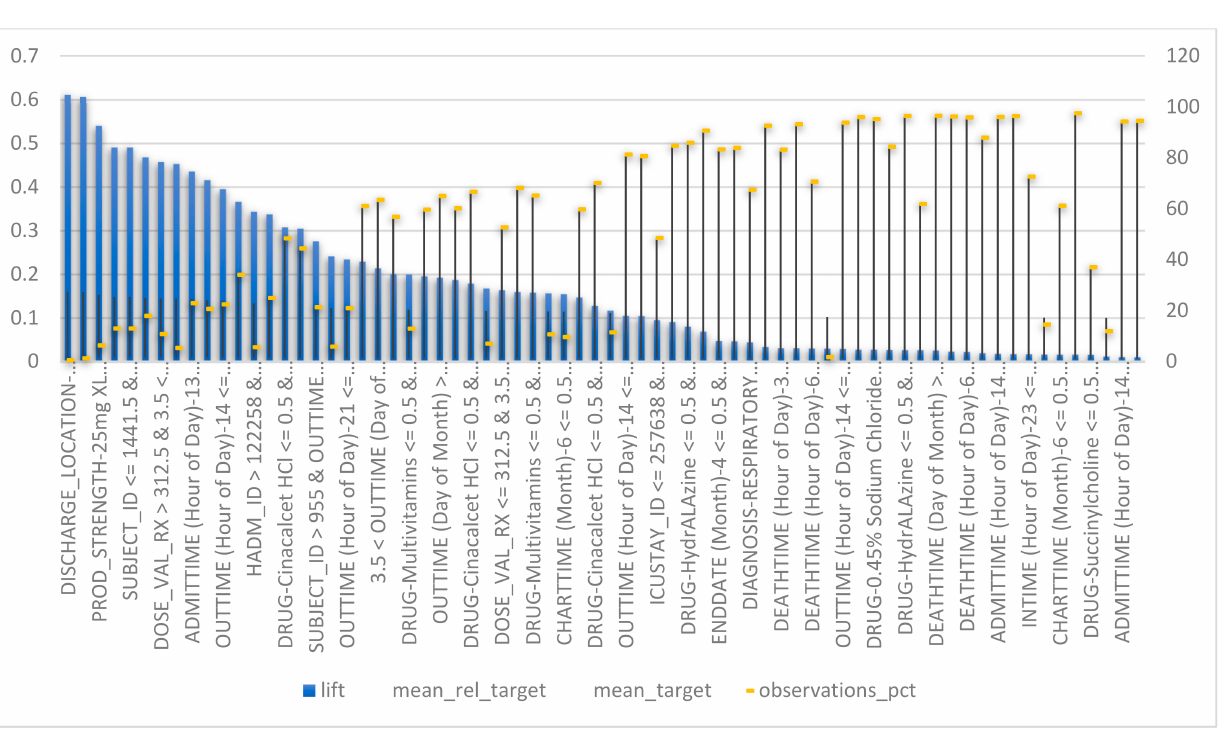
Figure 5. MIMIC III: training